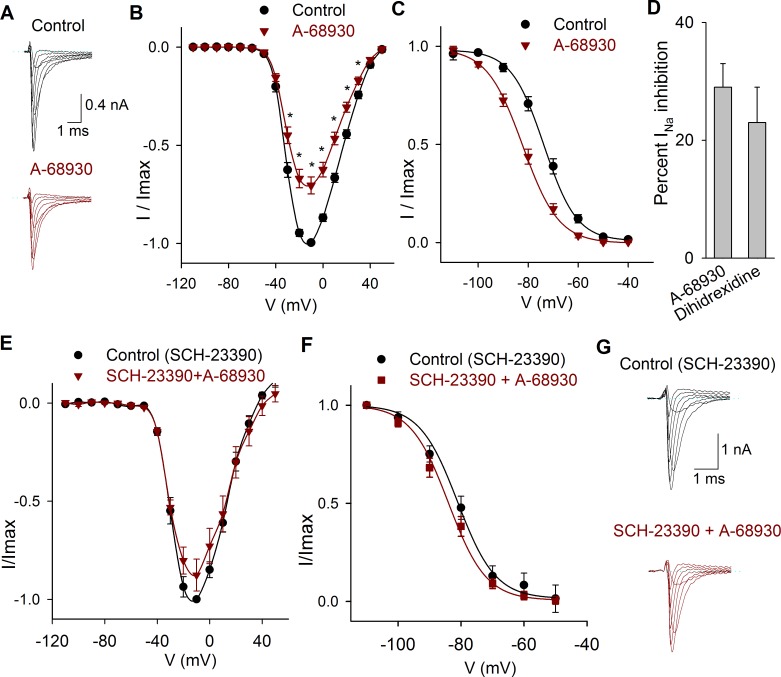
Effects of D1 related drugs on the INa.A) Recordings of the INa in control condition and after perfusion of A-68930 (300 nM). B) Current-voltage relationship of the INa under control conditions and after 300 nM A-68930. The maximum decrease of the current was 29 ± 4% at −10 mV. C) Steady state inactivation of the INa in control conditions and after 300 nM A-68930, which caused a leftward shift of the inactivation. D). Bar graph comparing the inhibitory effect of 100 nM dihidrexidine with A-68930 effect. Non-significant difference was found (P = 0.445; unpaired t-test). E) Current-voltage relationship of the INa in control conditions (with 100 μM SCH-23390), and after the co-application of 300 nM A-68930. F) Steady state inactivation of the INa in control (with 100 μM SCH-23390) and after A-68930 + SCH-23390, which caused non-significant changes. G) Typical recordings of the INa showing that SCH-23390 significantly reduced the inhibitory action of 300 nM A-68930.